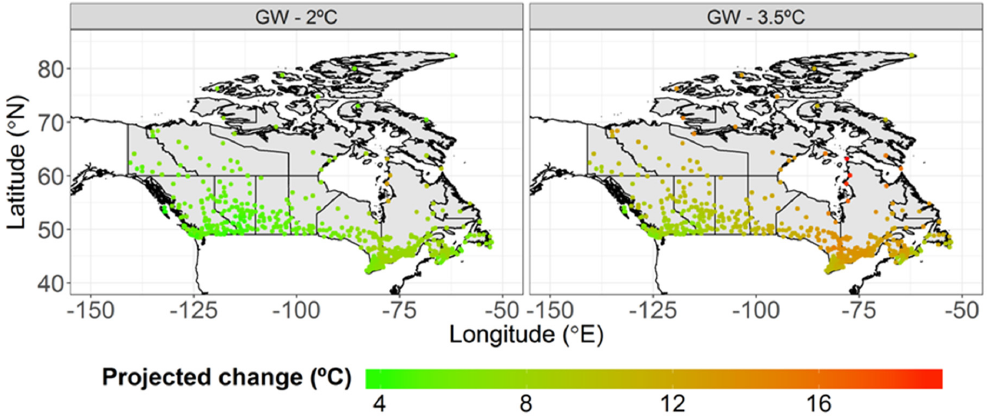
Figure 5. Projected changes in January 1% design temperatures in Canada under globally averaged warming of 2 °C and 3.5°.